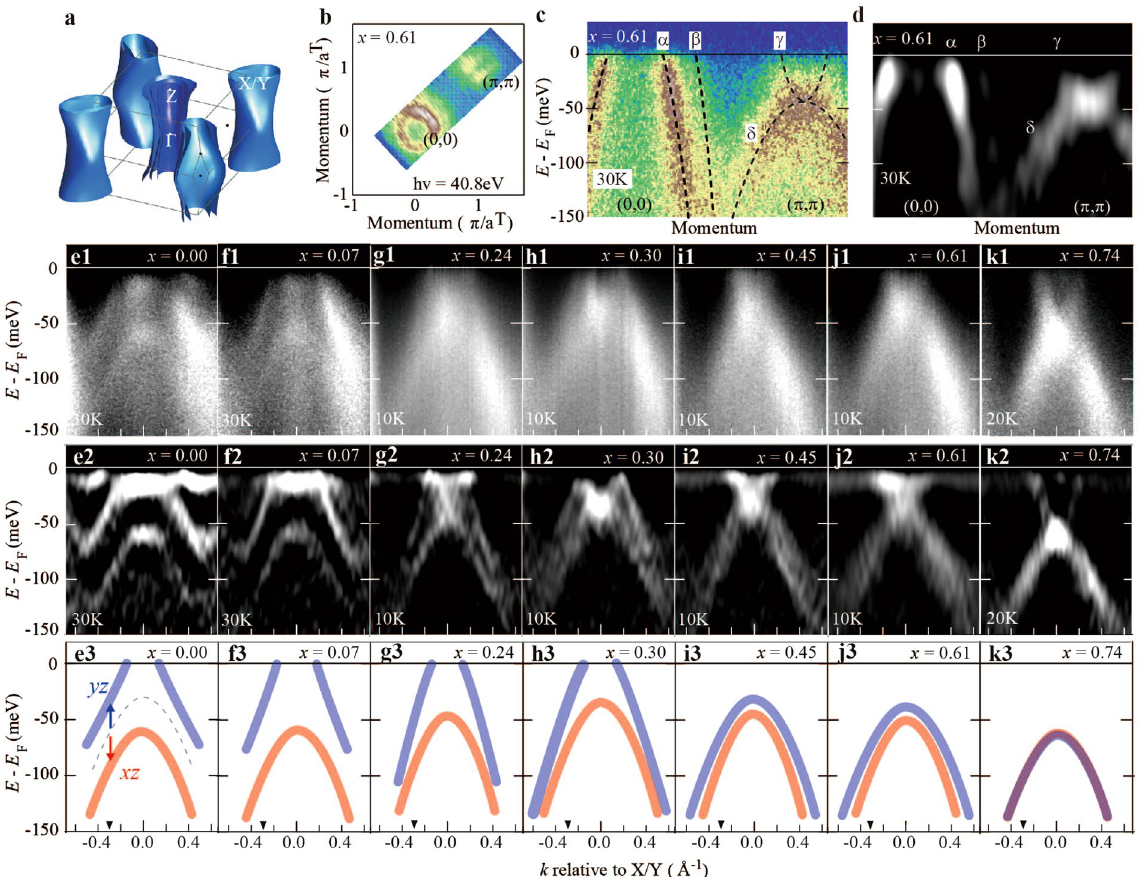
Figure 1. ( a ) First-principles band calculations of FSs for x = 0.00. (b) FS mapping at x = 0.61 by h ν = 40.8 eV. a T represents the inplane lattice parameter of the tetragonal structure. (c , d) E - k image and its second E derivative image for x = 0.61 along (0,0) – ( π , π ) direction. Two electron bands crossing E F around ( π , π ) is not separately detected in this experimental condition. ( e1 – k1 ) E - k images at the BZ corner on twinned crystals of 0.00 ≤ x ≤ 0.74. ( e2 – k2 ) The second E derivative E-k images of 0.00 ≤ x ≤ 0.74. ( e3 – k3 ) Schematic band dispersions obtained from (e2) to (k2). Blue and red curves correspond to the band dispersions of yz and xz orbitals, respectively. Broken curve in (e3) shows the degenerate xz/yz band at higher T